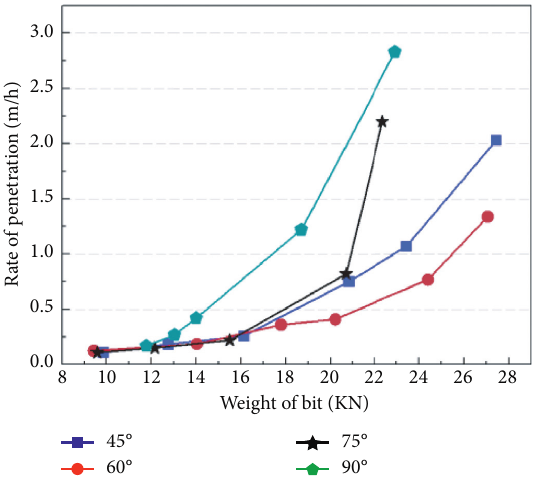
Figure 30: Relationship between WOB and ROP with α change of bits